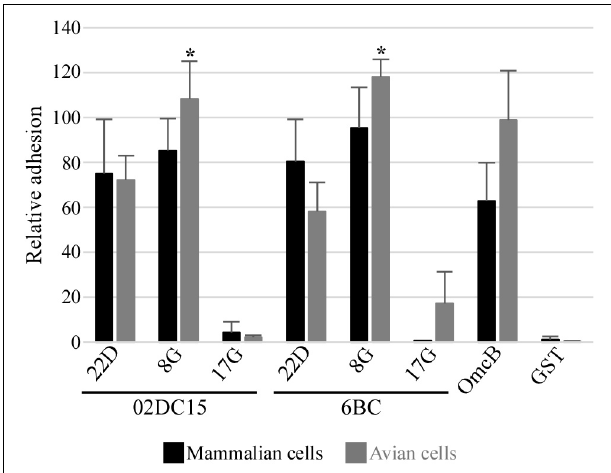
FIGURE 5 | Adhesion ability of different Pmps from mammalian and avian C. psittaci strains. Adhesion ability of 200 µ g/ml soluble recombinant Pmp22D, Pmp8G, and Pmp17G from mammalian C. psittaci 02DC15 and avian 6BC strains. Recombinant OmcB and GST were used as positive and negative control, respectively. Comparison of adhesion intensity of the different rPmps and control proteins to confluent McCoy mammalian fibroblasts (black) and UMNSAH/DF-1 avian fibroblasts (gray). Adhesion abilities were evaluated by immunoblotting and the intensity of the bands was measured with ImageJ and expressed as a percentage of the input loading band of the respective protein. Relative adhesion represents the mean of three independent replicates ( n = 3). p -values were calculated using paired t -test, by comparing the relative adhesion of each Pmp to the two cell lines. * p <